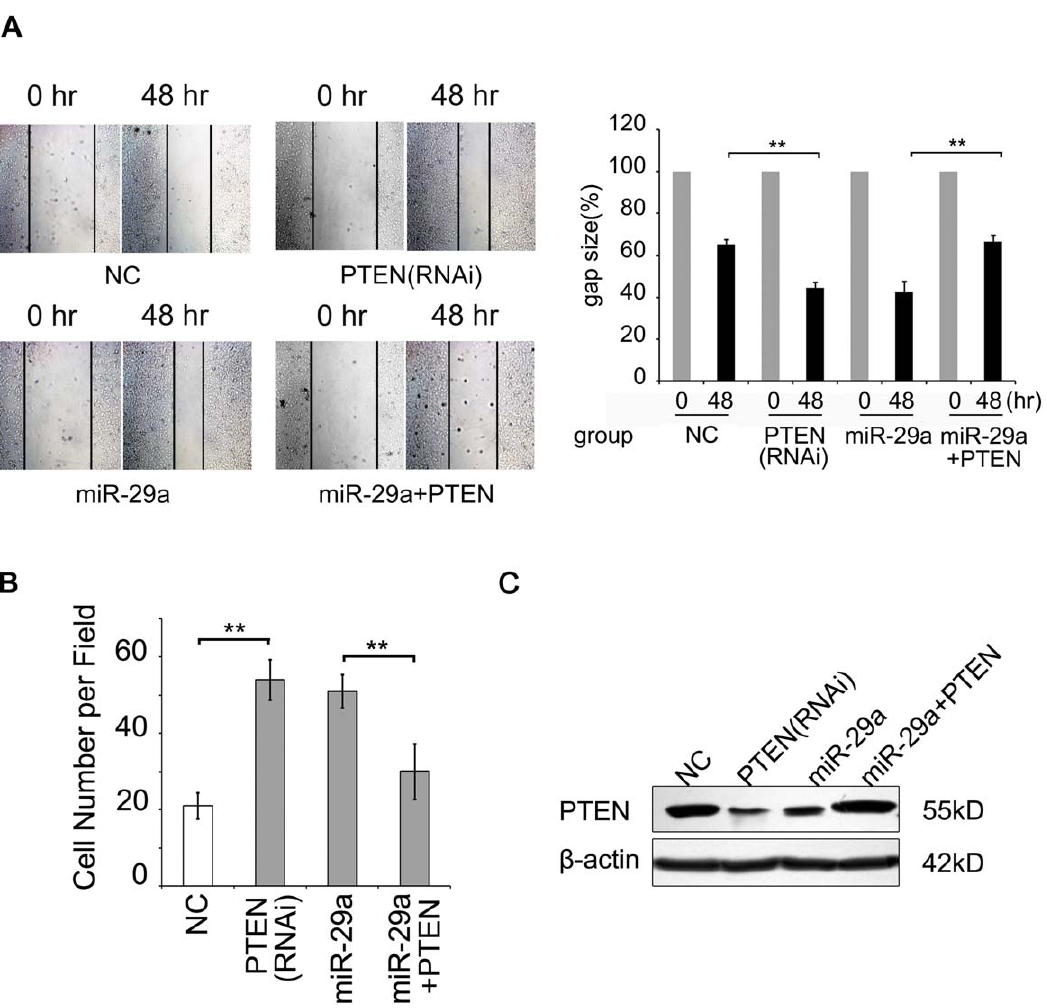
Figure 4. PTEN inhibits migration of tumor cells. (A) A wound healing assay was performed on HepG2 cells (1 6 10 6 , 6-cm plate) transfected with random siRNA, PTEN siRNA, pcDNA3-29a, and both pcDNA3-PTEN/pcDNA3-29a, respectively. One representative experiment is shown. Black arrows indicate the wound edge. (B) Modified Boyden’s chamber assays showed that enhanced cell migration induced by miR-29a was reversed by the overexpression of PTEN in HepG2 cells. A histogram shows the relative cell number of five randomly selected fields. (C) The expression of PTEN was detected by western blot analysis in above transfected HepG2 cells. Statistically significant differences are indicated: *P , .05, **P , .01, Student’s t